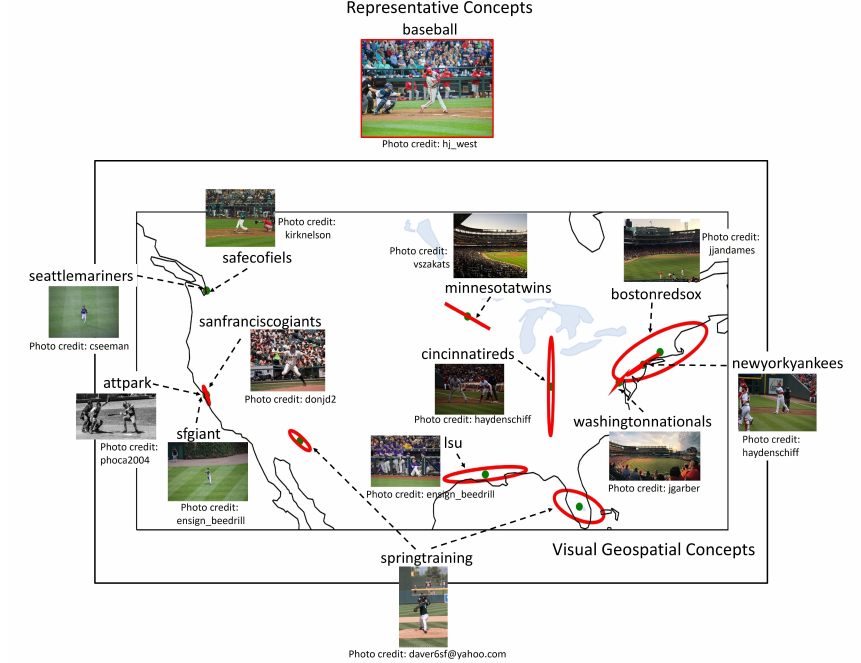
Figure 11. Examples of visual geospatial concepts represented by a visual concept baseball . The edges among the visual geospatial concepts and baseball are omitted for visual clarity.